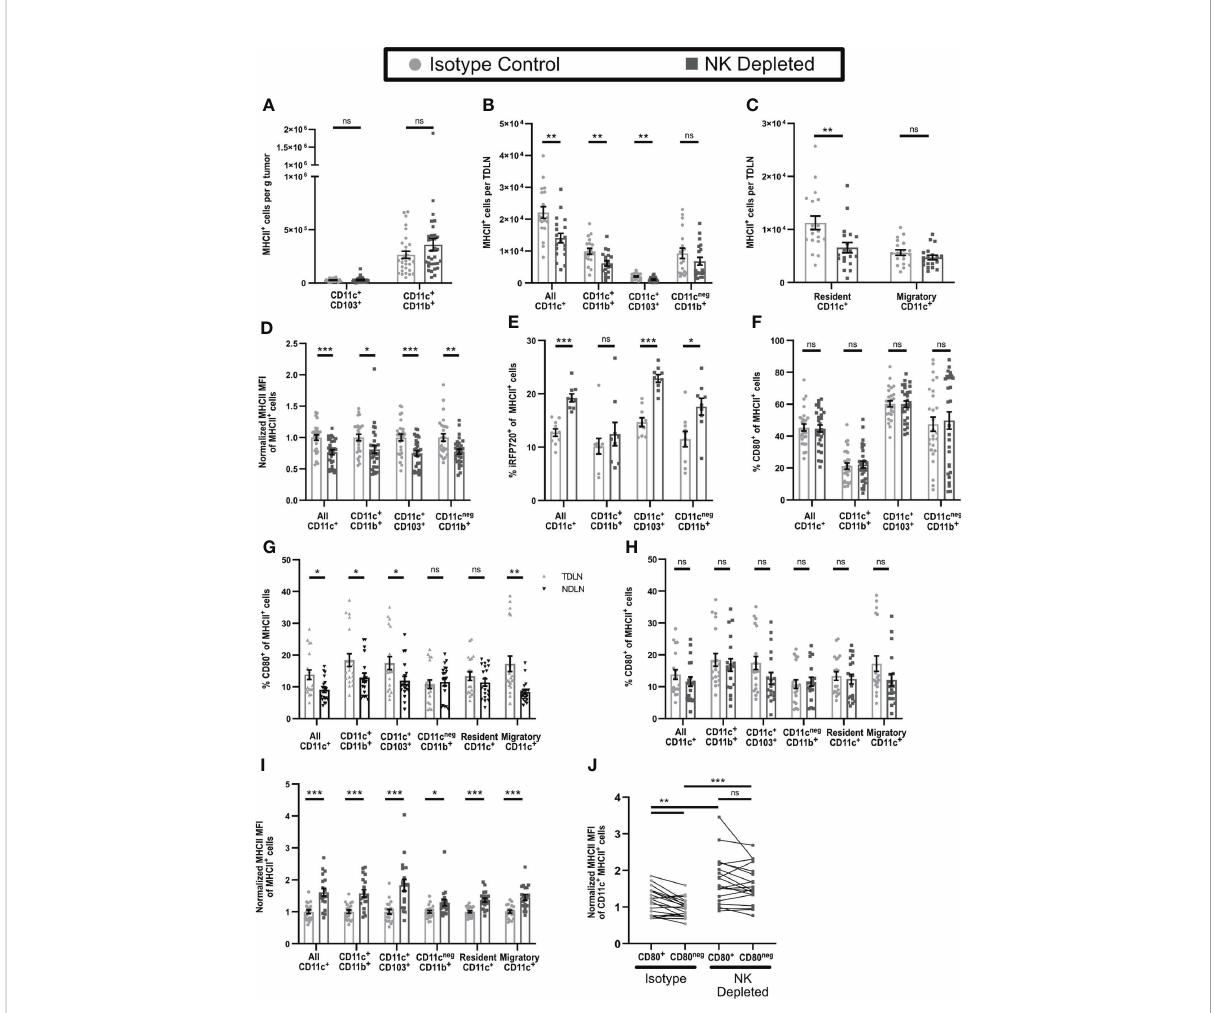
FIGURE 6 Antigen presenting cells in tumors and TDLN of mice lacking NK cells have an altered maturation phenotype. (A – D, F – J) B16-ova or (E) B16- ova-iRFP720 tumors were implanted into WT B6 mice treated with isotype control or anti-NK1.1 depleting antibody on D-2, D1, and D4. Tumor (A, D – F) , TDLN (B, C, G – J) , or NDLN (C) were harvested on D7. Single cell suspensions were analyzed by fl ow cytometry. (C, G – I) Resident APC were de fi ned as CD11c Hi MHCII Int and Migratory APC as CD11c Low MHCII Hi . (I, J) For each APC subset, MHCII MFI was normalized to the isotype control average of that same subset (I) or of all CD11c + MHCII + APC (J) separately for each experiment. (B, C, G – J) Data are from 4 experiments; (A, D, F) Data are from 6 experiments; (E) Data are from 2 experiments. Statistics: (A – I) Unpaired Student ’ s T test with Welch ’ s correction; (J) For CD80 + vs CD80 neg comparisons, a paired T test was used. For comparisons between isotype and NK depleted, an Unpaired Student ’ s T test with Welch ’ s correction was used. *p < 0.05; **p < 0.01; ***p < 0.001; ns, not signi fi